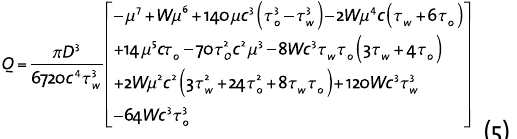
Figure 1: Relative velocity profile for a Newtonian liquid (black), a Bingham liquid (grey, dashed) and a modified Bingham liquid (grey,